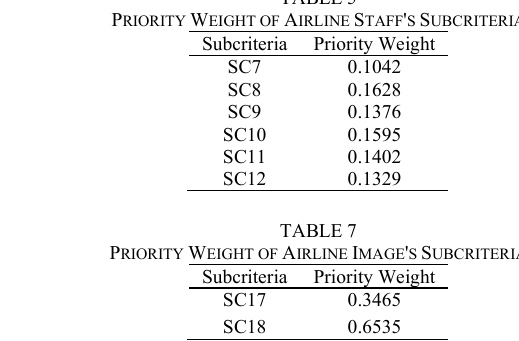
TABLE 5 P RIORITY W EIGHT OF A IRLINE S TAFF ' S S UBCRITERIA